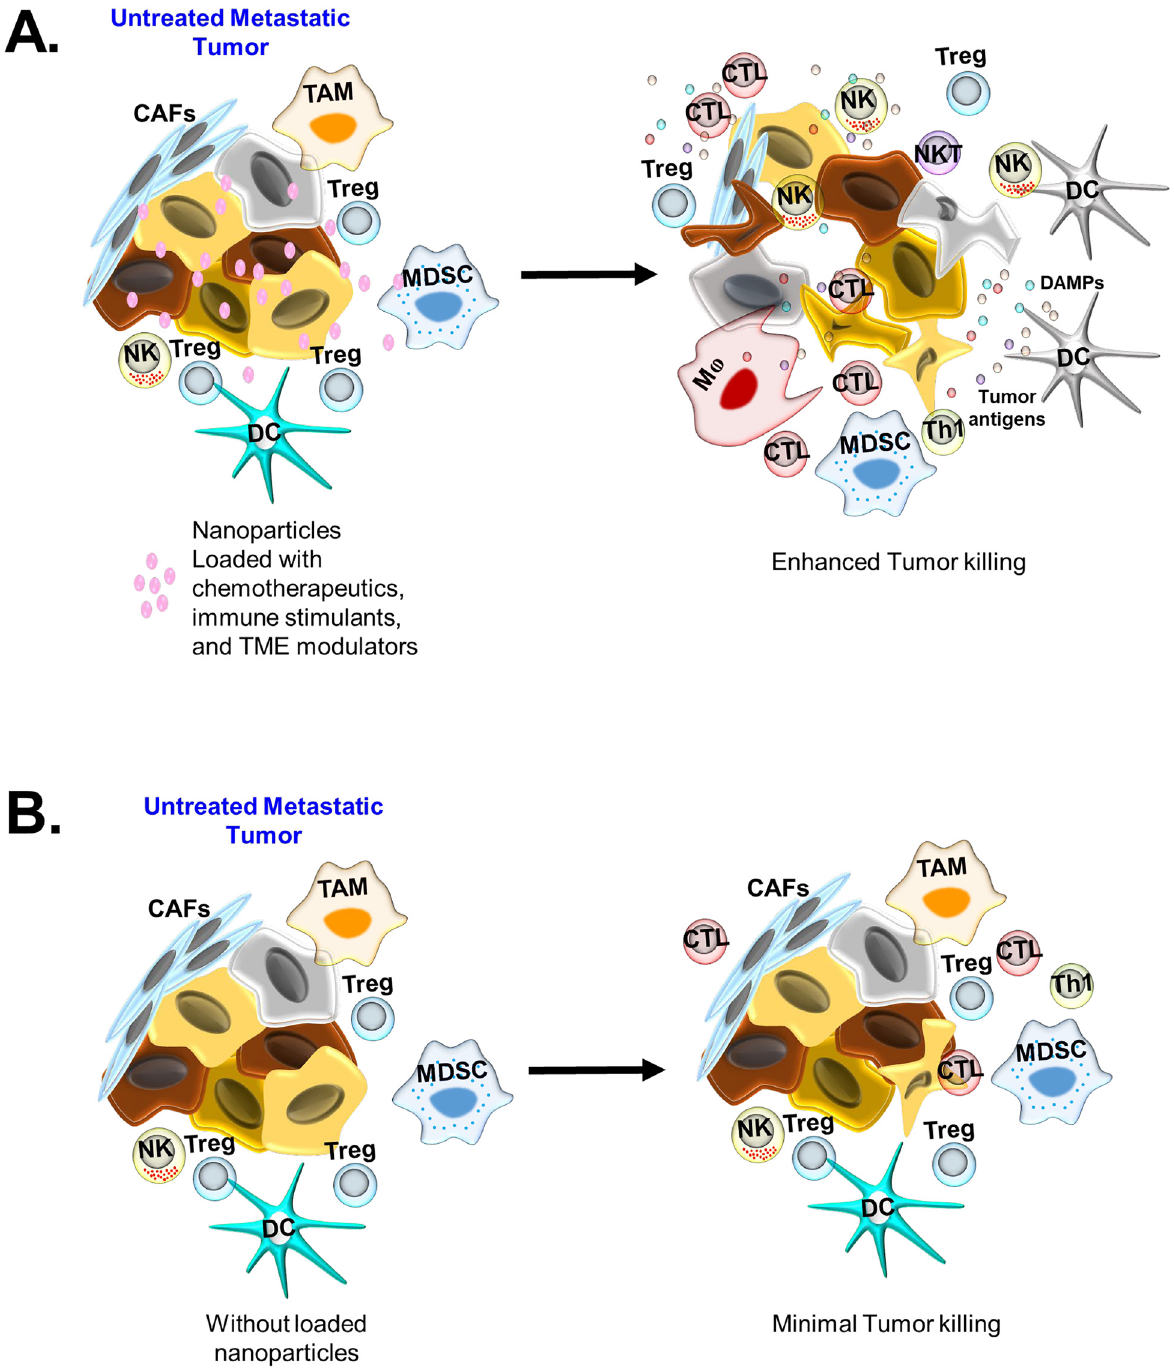
Figure 2: Illustration of the addition of nanoparticles loaded with chemotherapeutics, immune stimulants, and TME modulators, as well as their effects on the untreated metastatic